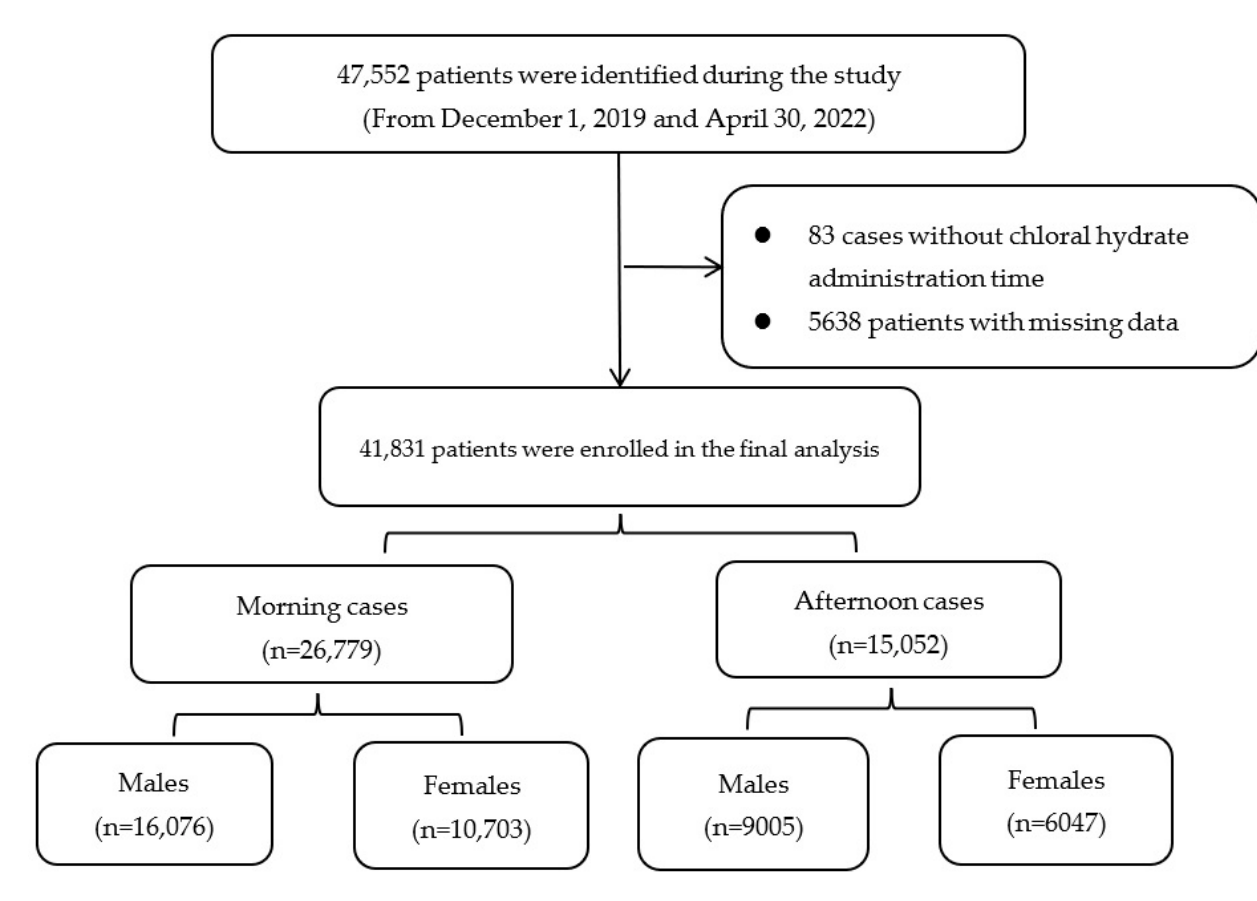
Figure 1. Study flow chart .